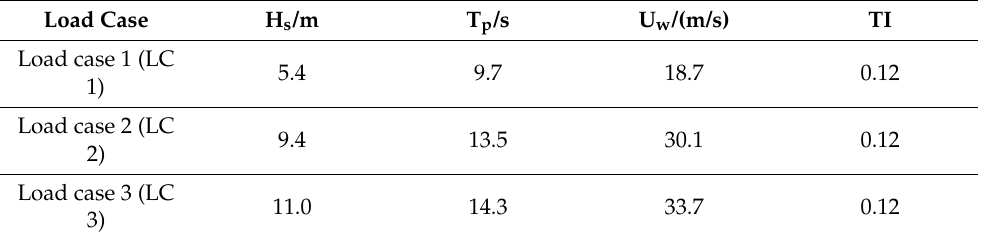
Table 4. Load Case